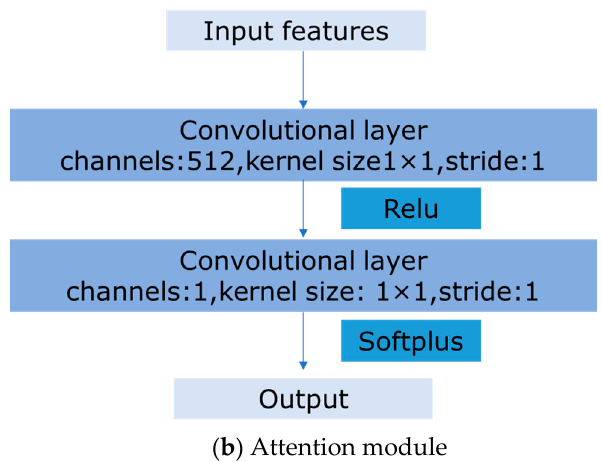
Figure 3. Convolutional Neural Networks architecture and attention module.